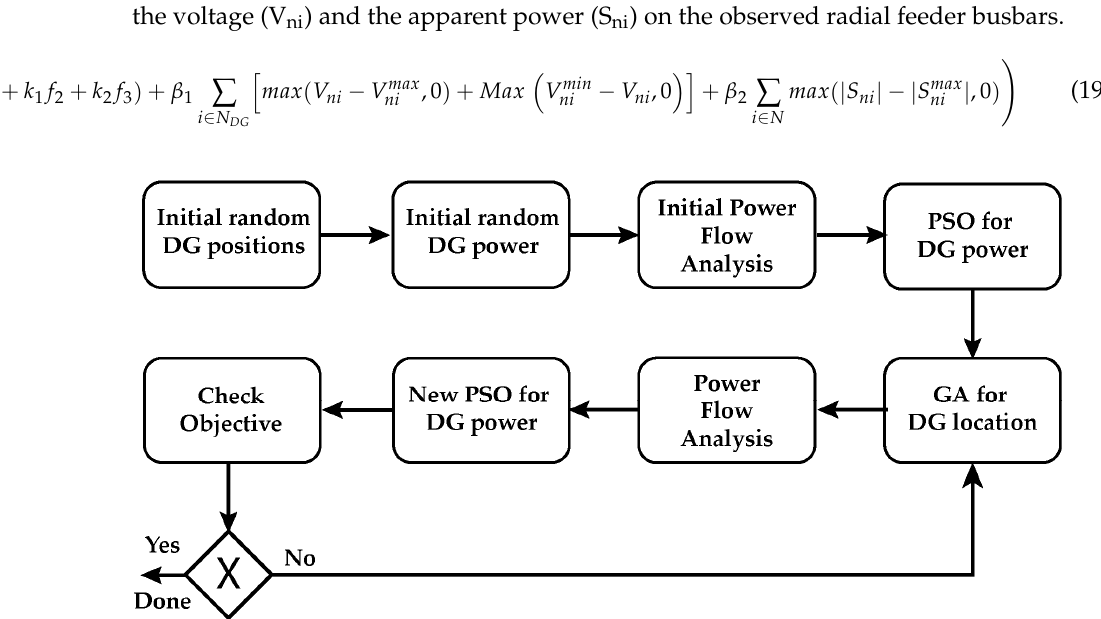
Figure 8 . Simplified illustration of PSO and GA hybrid method by Moradi and Abedini. Figure 8. Simplified illustration of PSO and GA hybrid method by Moradi and